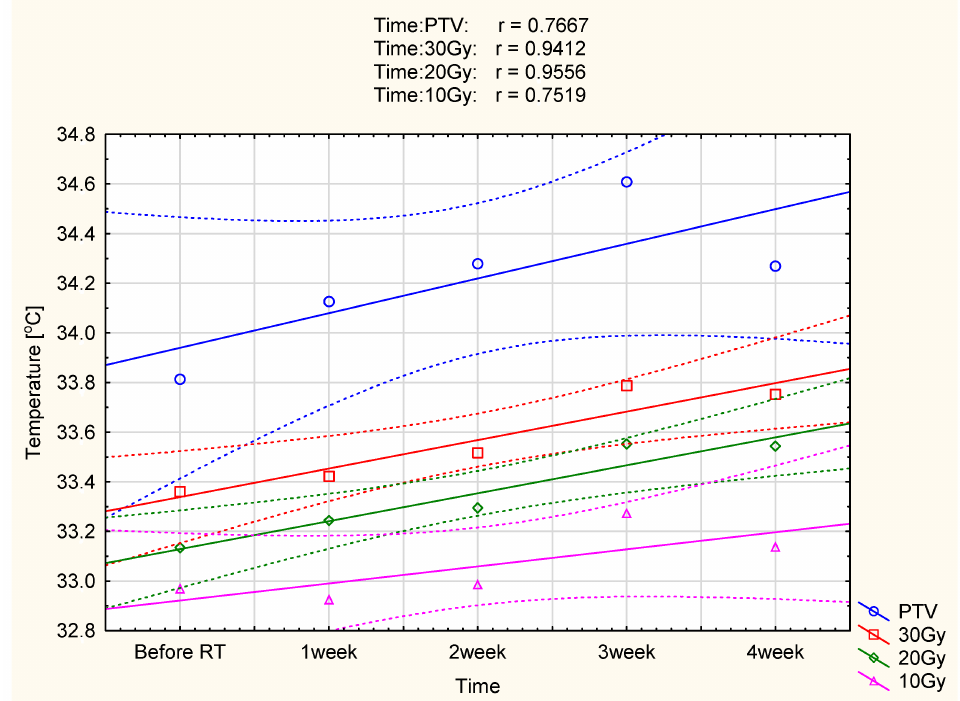
Figure 3. Correlation of temperature changes with the time of radiotherapy digestion for the PTV area and 30 Gy, 20 Gy, and 10 Gy isodoses in 23 patients after mastectomy. The confidence interval was